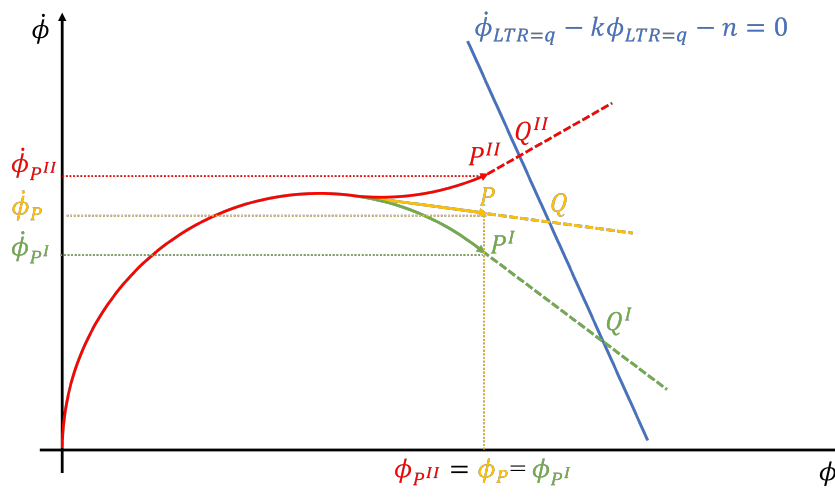
Figure 12. Schematic principle of the ILPT